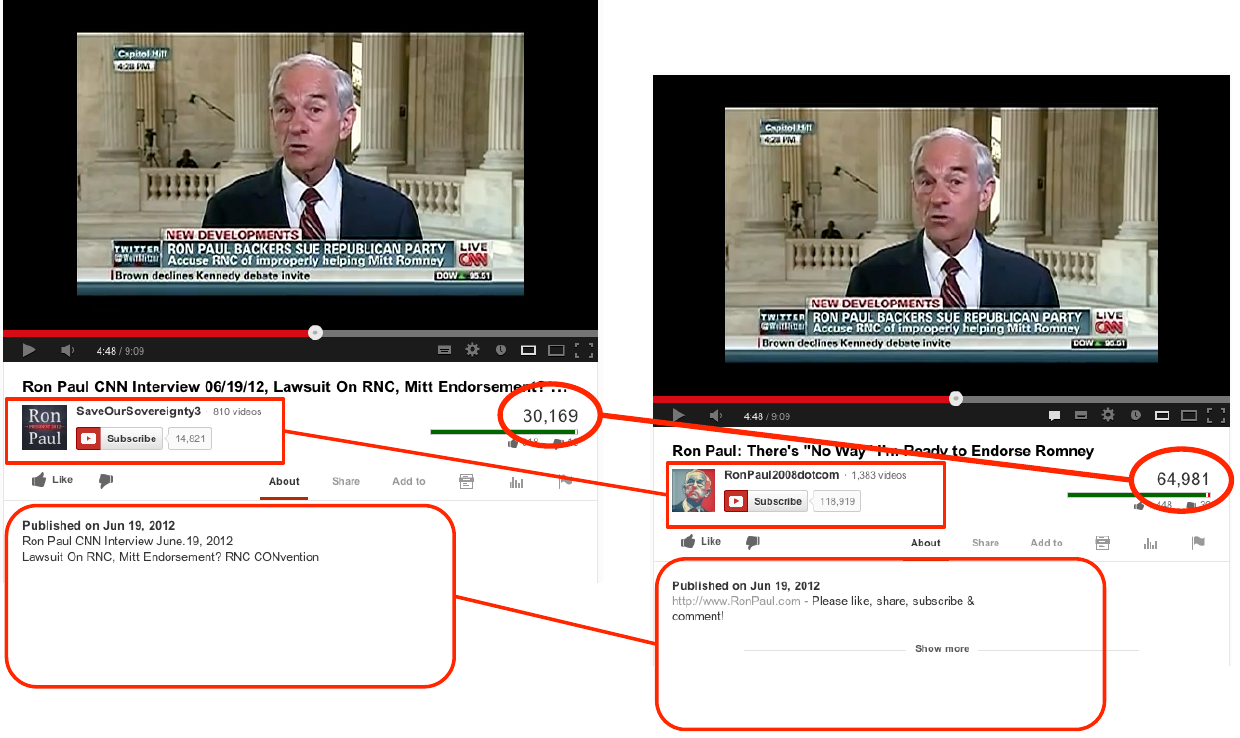
Figure 1. Illustration of duplicate videos on YouTube, with the non-overlapping social commentary from different subsets of the user community highlighted. Fully automated video analysis techniques are able to detect these duplicates, and by recognising that the social commentaries are referring to the same content, they can be